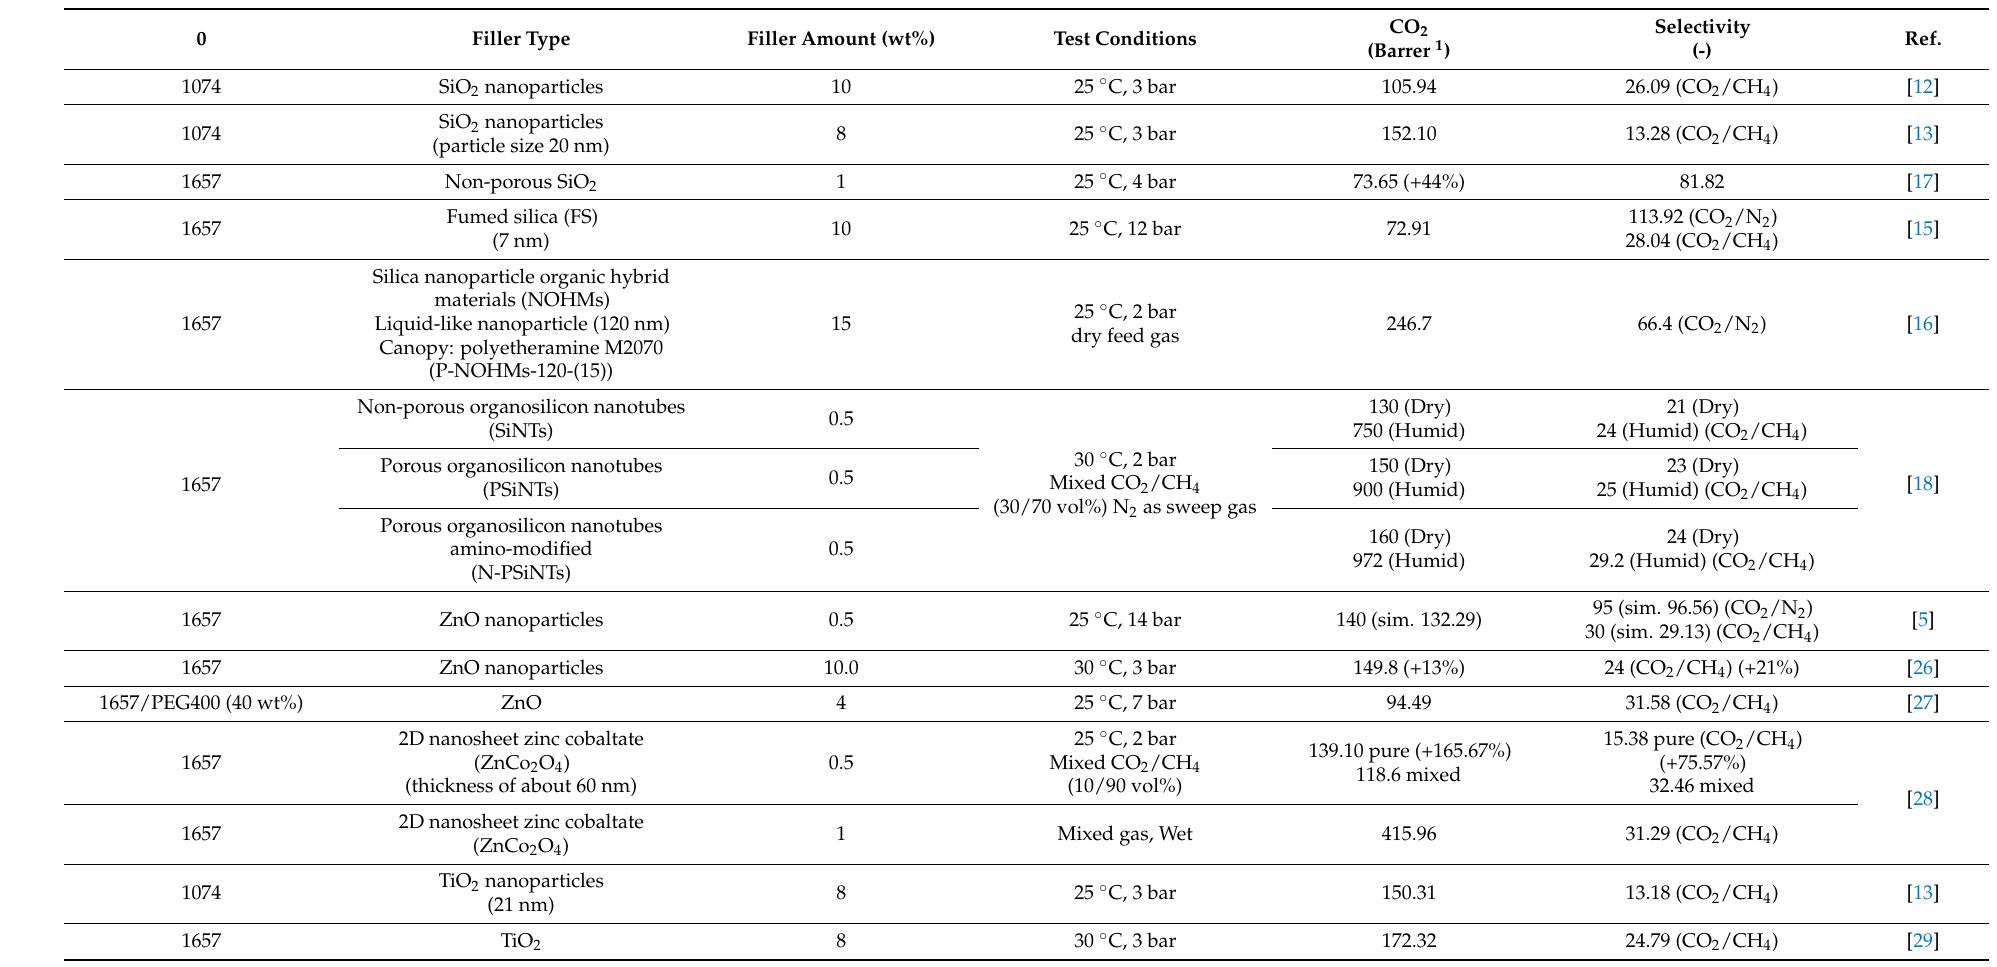
Table 4. Permeation properties of selected Pebax-based MMMs filled with inorganic (typically non-porous)